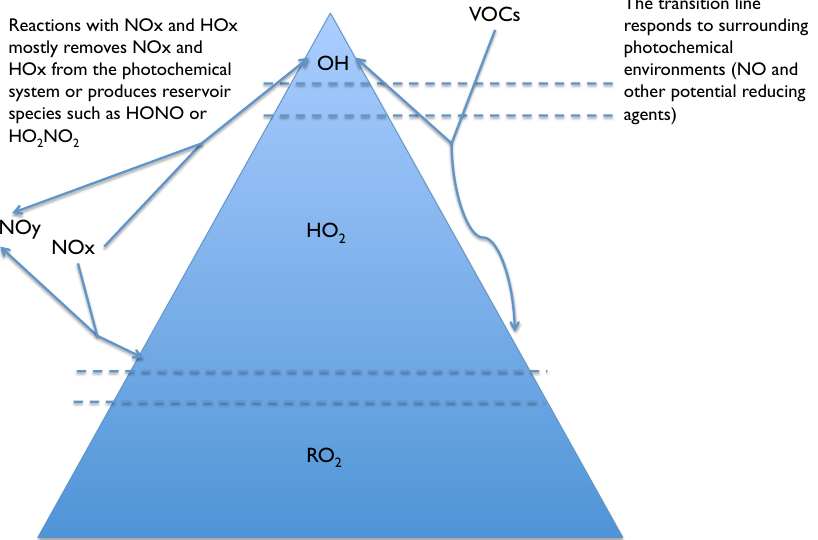
Fig. 9. Tropospheric interactions of oxidant pool NO x -NO y -VOCs (NO y , reactive oxidized nitrogen). VOC oxidation by OH redistributes within the oxidant pool but does not change the size of the